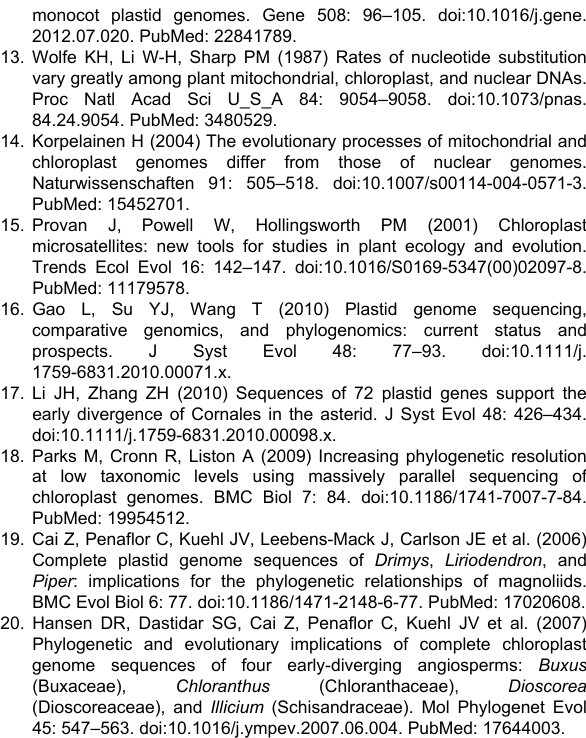
Figure S1. Maximum parsimony trees of 26 fast evolving DNA regions in seven Araliaceae species. The numbers above branches indicate parsimony bootstrap values (PB) for maximum parsimony analysis.